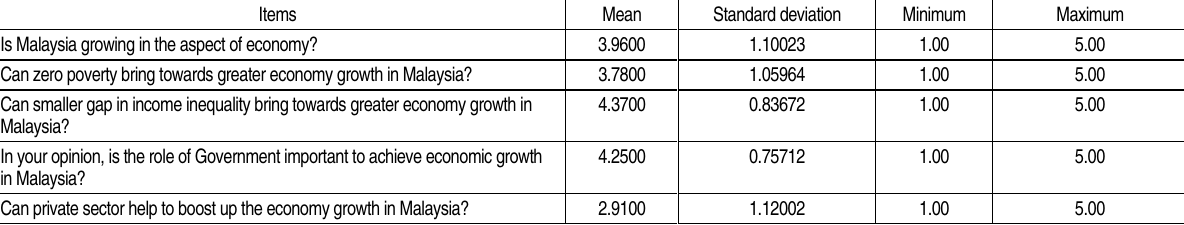
Table 6. Mean and standard deviation of economy growth